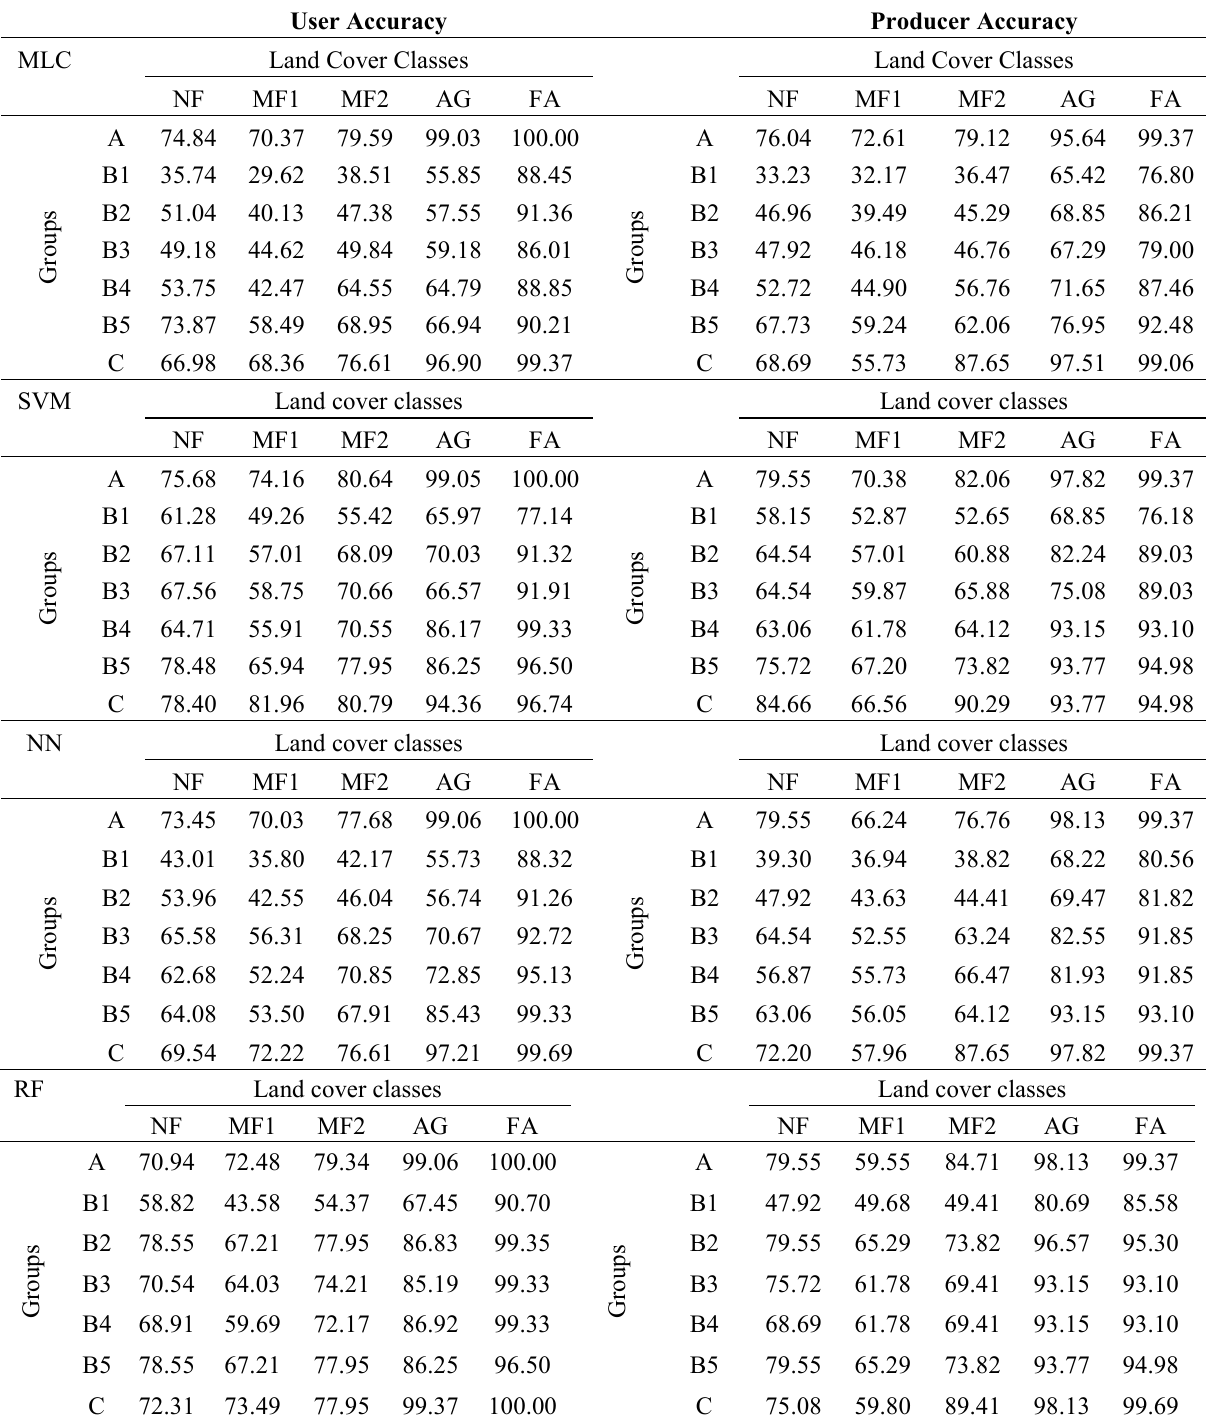
Table 9. User/producer accuracy. See Tables 1 and 5 for the descriptions of land cover classes and